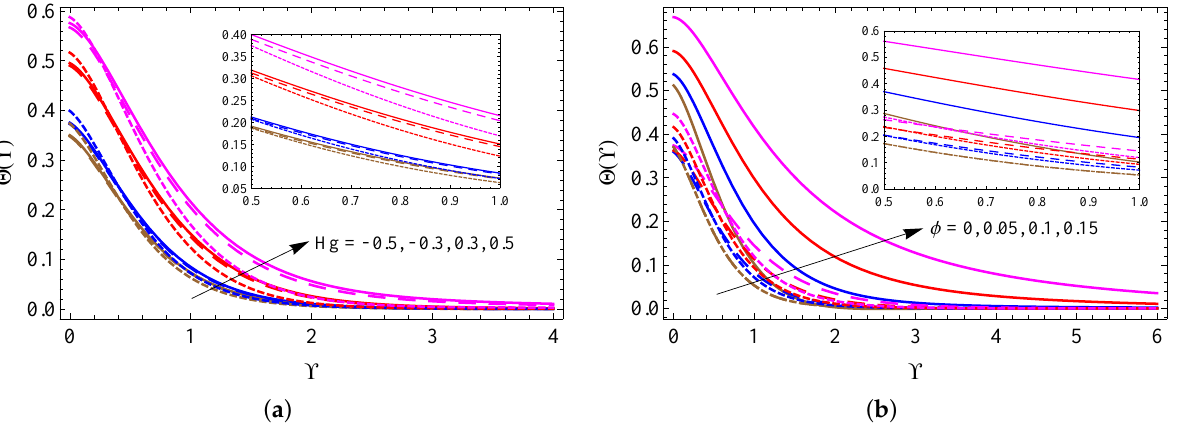
Figure 6. The contrast of Θ ( Υ ) against Hg ( a ) and φ ( b ) for SWCNTs (solid line), MWCNTs (dashed line) and Al 2 O 3 nanofluid (dotted